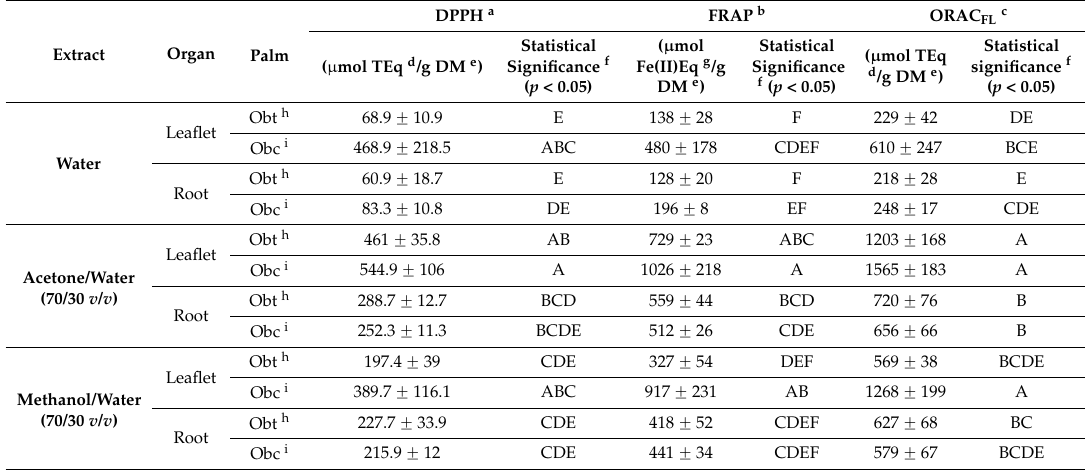
Table 2. Antioxidant activity of Oenocarpus bataua and Oenocarpus bacaba leaflet and root extracts.